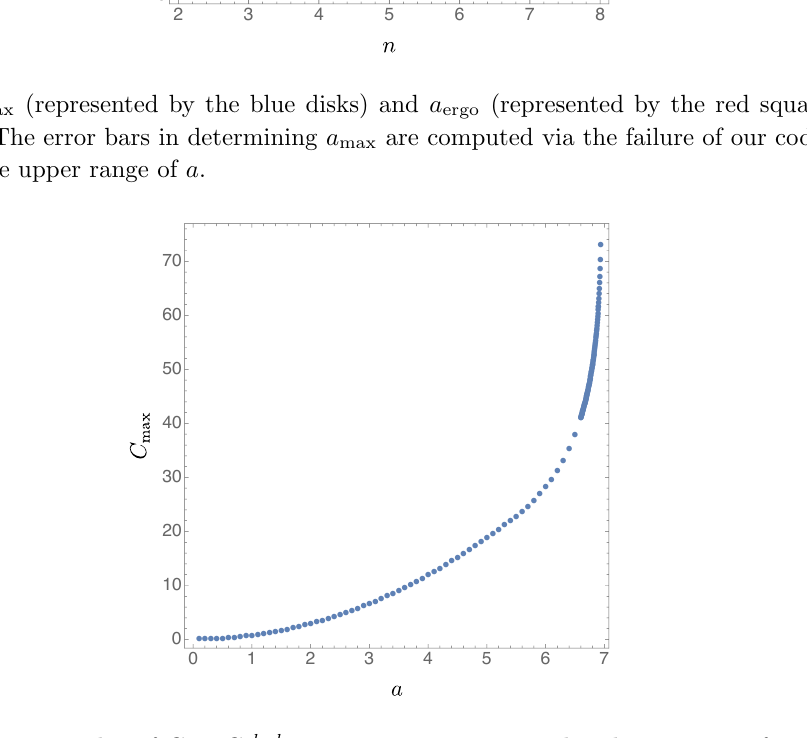
panel) and n = 8 (right panel). Since the rotation axis corresponds to ~ x = 0, it is clear